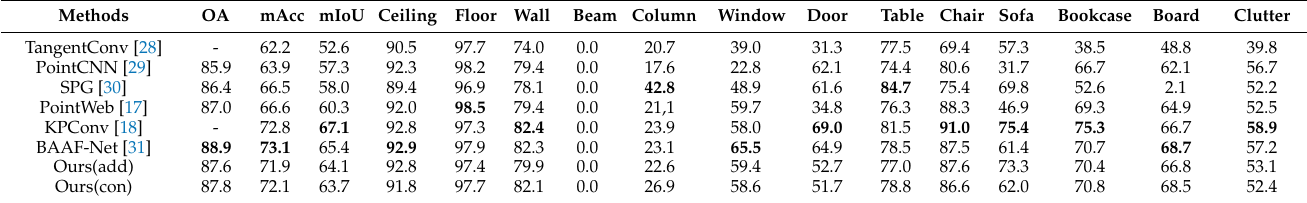
Table 1. Segmentation results on area 5 of S3DIS (add: the two attention weight matrices added; con: the two attention weight matrices fused at the feature